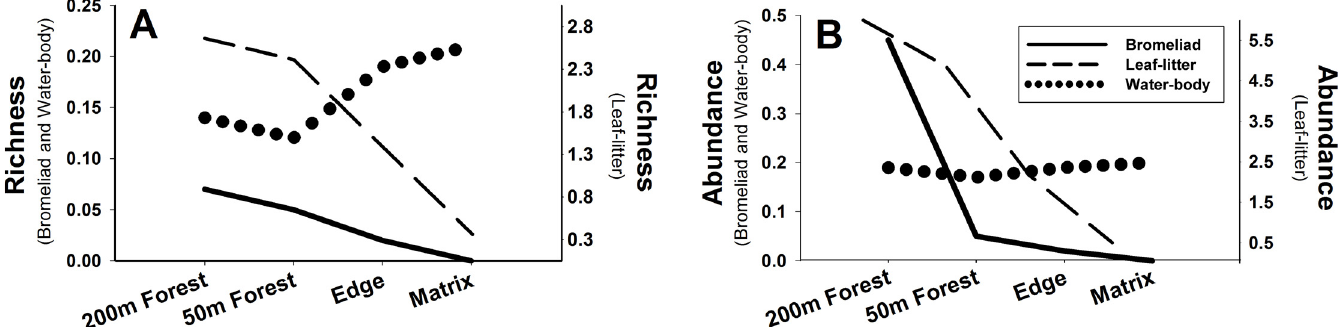
Fig 2. Response to edge effect by breeding guild. (A) Mean richness and (B) abundance of breeding guilds across distance from the forest edge across 21